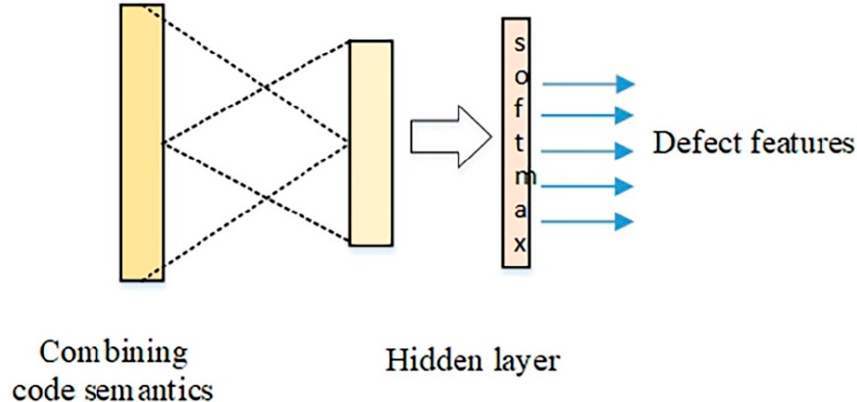
Figure 2. The process for the CNN network to mine a defect feature.